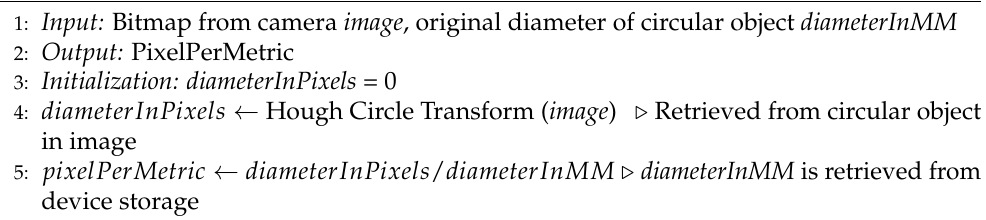
Algorithm 1 Pixel Per